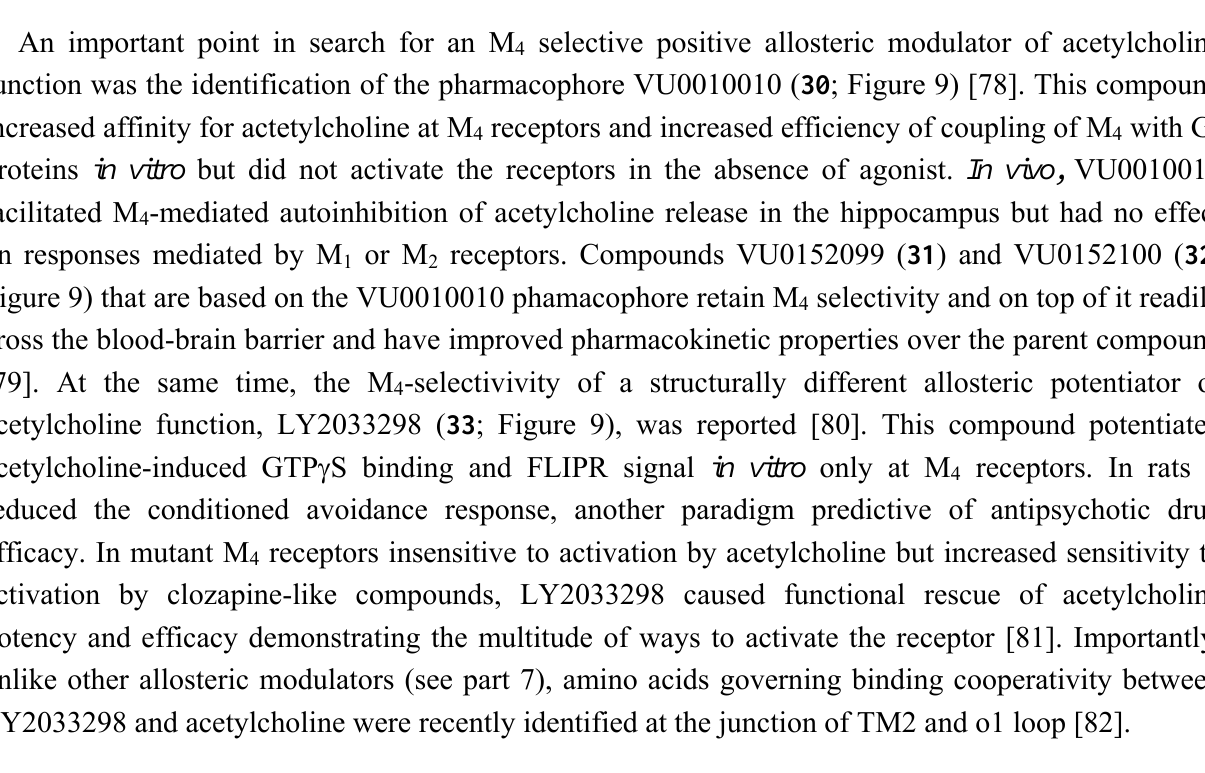
-selective allosteric 4